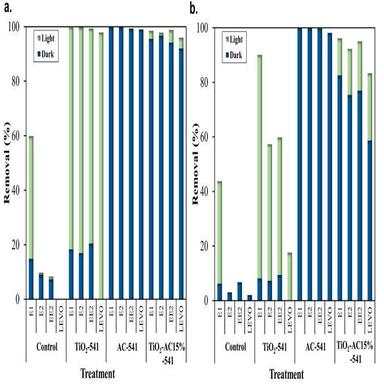
Removal efficiency (%) of E1, E2, EE2 and LEVO. Fig. 10a. Experimental conditions: o = 60 μg L− 1 , o = 60 μg L− 1 , o = 60 μg L− 1 and o = 60 μg L− 1 in 100 mL of solution; simulated solar light irradiation: 25 W m− 2 . (i) Control (hormones solution without any material TiO2-541, AC-541, or composite), 120 min of reaction in dark followed by 120 min with lights on (photolysis); (ii) TiO2-541 (hormones solution with bare TiO2 previously exposed to the same temperature of 541 ◦C applied for composite c